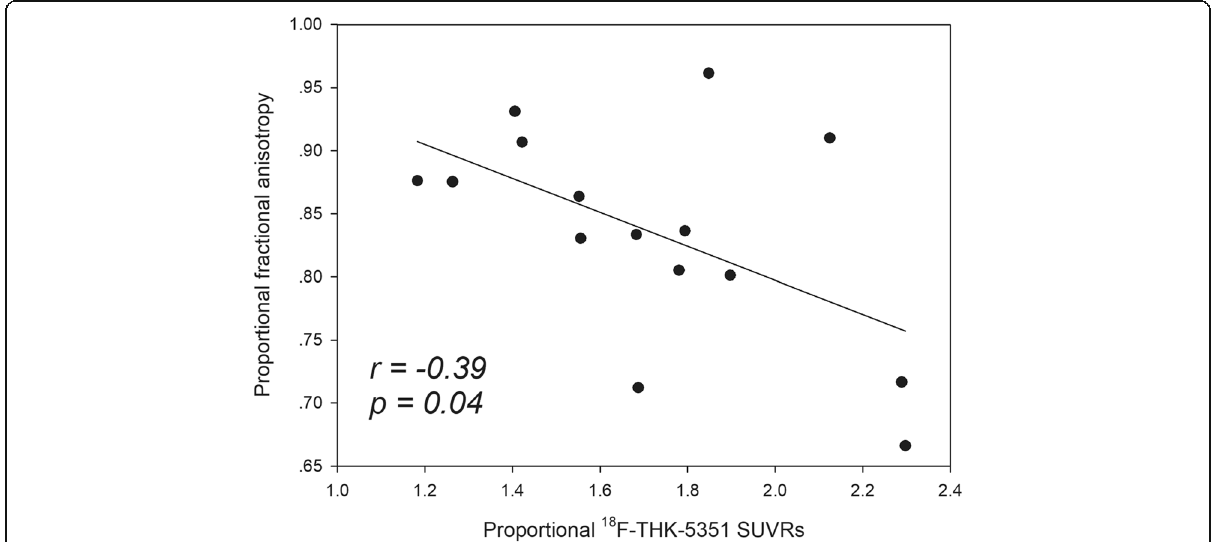
Fig. 3 Correlation of the proportional 18 F-THK-5351 standardized uptake value ratios (SUVRs) with the proportional fractional anisotropy (FA) values. The proportional 18 F-THK-5351 SUVRs are negatively correlated with the proportional FA values, suggesting that peri-ischemic areas with higher 18 F-THK-5351 retention have worse microstructural